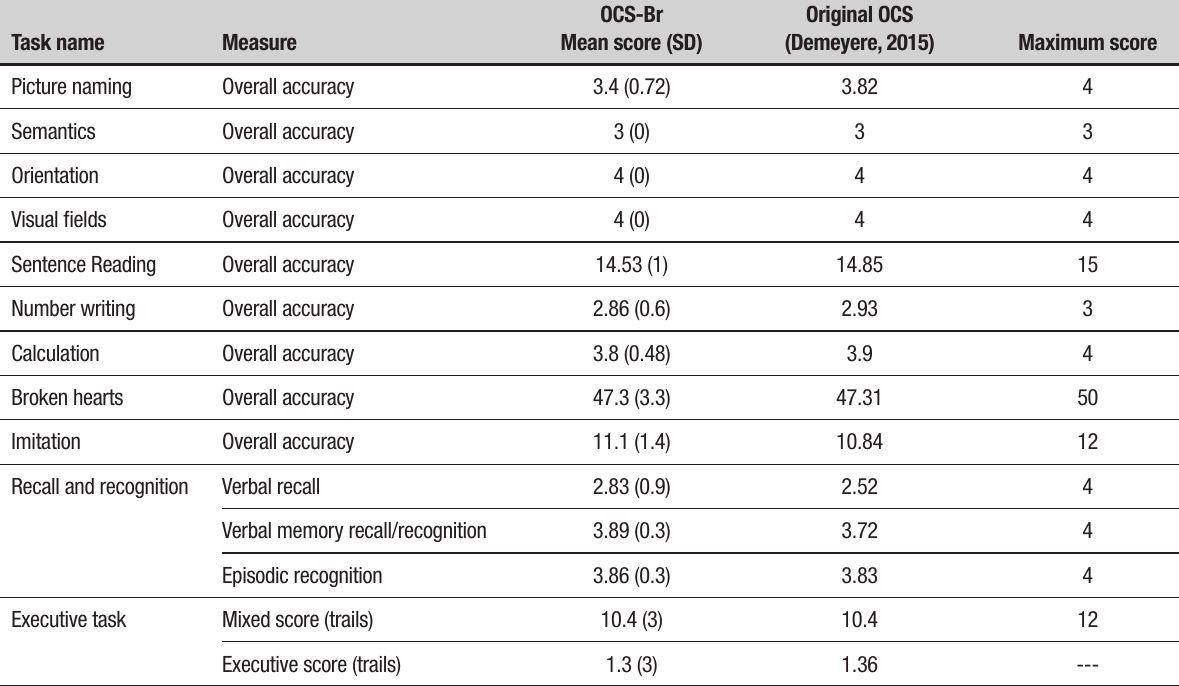
Table 2. Scores on subitems of OCS-Br compared to the original